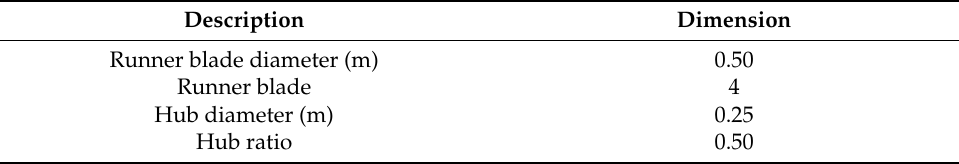
Table 2. Main design parameters of the turbine